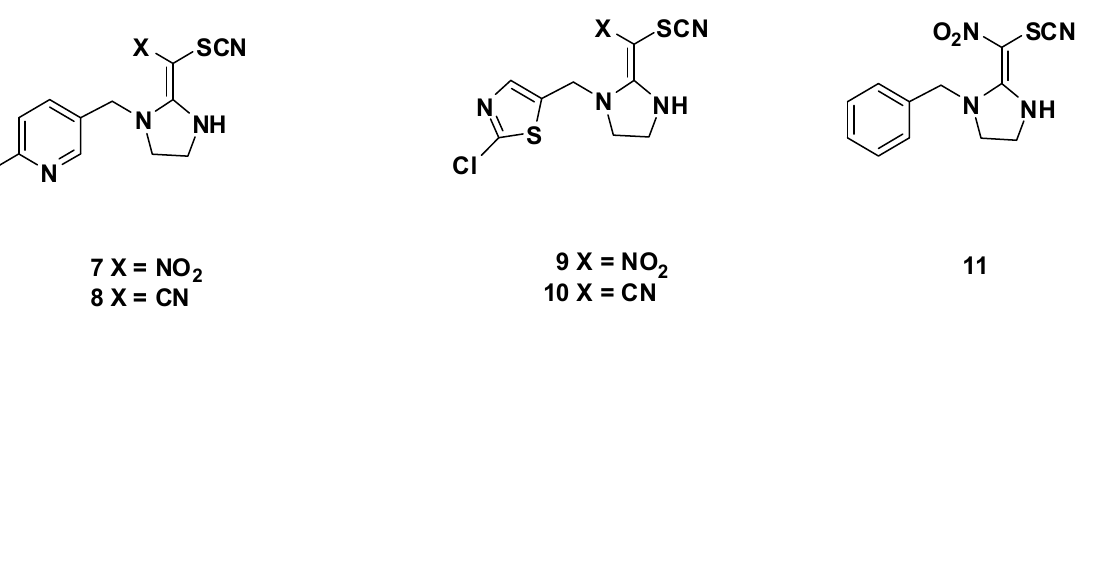
Figure 3. Chemical structures of novel neonicotinoid analogues under